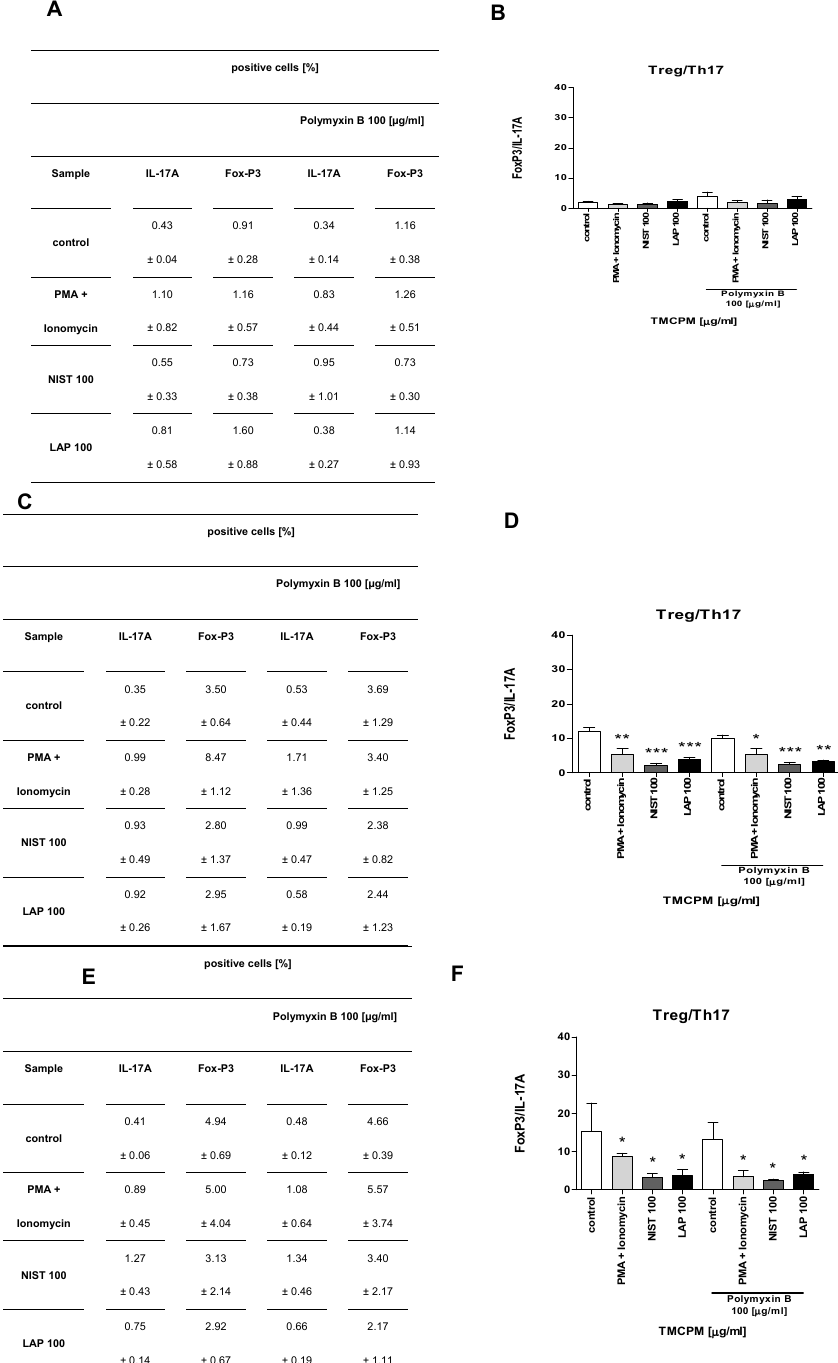
Figure 8. Effect of the exposition of T lymphocytes ( A , B ), PBMC ( C , D ) and T lymphocytes with monocytes added ( E , F ) to TMCPM (NIST or LAP) pre-treated with polymyxin B (100 µ g / mL) on the Treg / Th17 ratio. Cells were stimulated as described in “Materials and Methods” with PMA (50 ng / mL) + ionomycin (100 ng / mL) (positive control) and with NIST or LAP (100 µ g / mL) pre-treated with Polymyxin B (100 µ g / mL). ( A , C , E ) Percentage of Th1, Th2, Th17, and Treg cells was quantified as the frequency of cells positive for IFN- γ , IL-4, IL-17A and FoxP3, respectively. ( B , D , F ) The ratio of the frequency (%) of FoxP3 positive to IL-17A positive CD4+ T cells (Treg/Th17) was calculated. The data are presented as mean ± SEM from four independent experiments performed. Differences between the groups were considered statistically significant at the following p values: * p < 0.1, ** p < 0.01, *** p < 0.001.